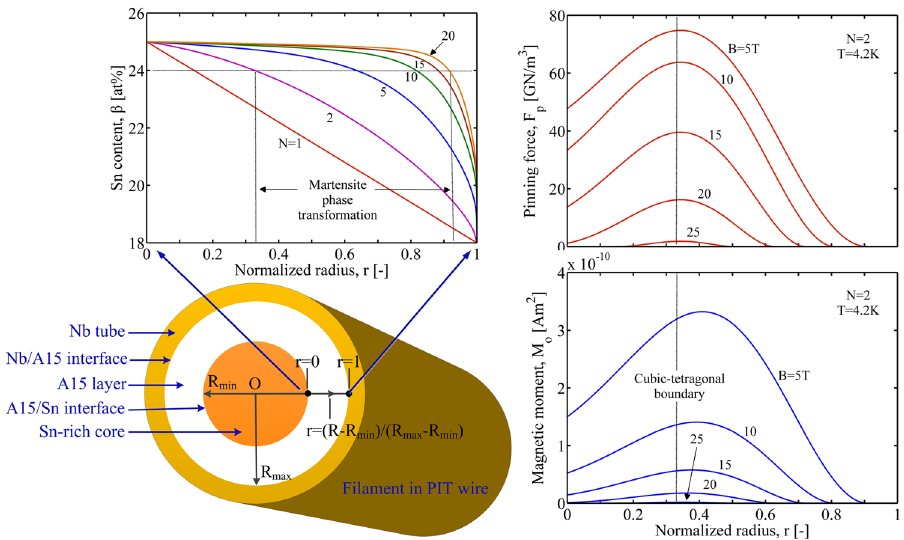
Figure 9. Distribution of the Sn content β (Top left), pinning force F p (Top right) and magnetic moment m o (Bottom right) on the cross section of PIT wire filament (Bottom left), at temperature T = 4.2 K. N indicates the severity of the overall